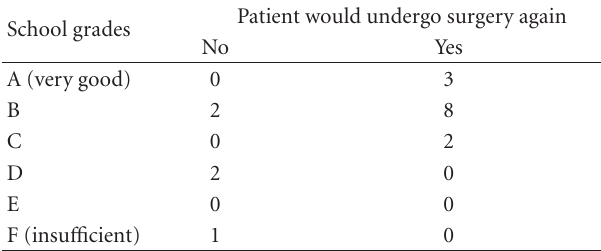
Table 3: How much has the reason of surgery (CTG) improved?